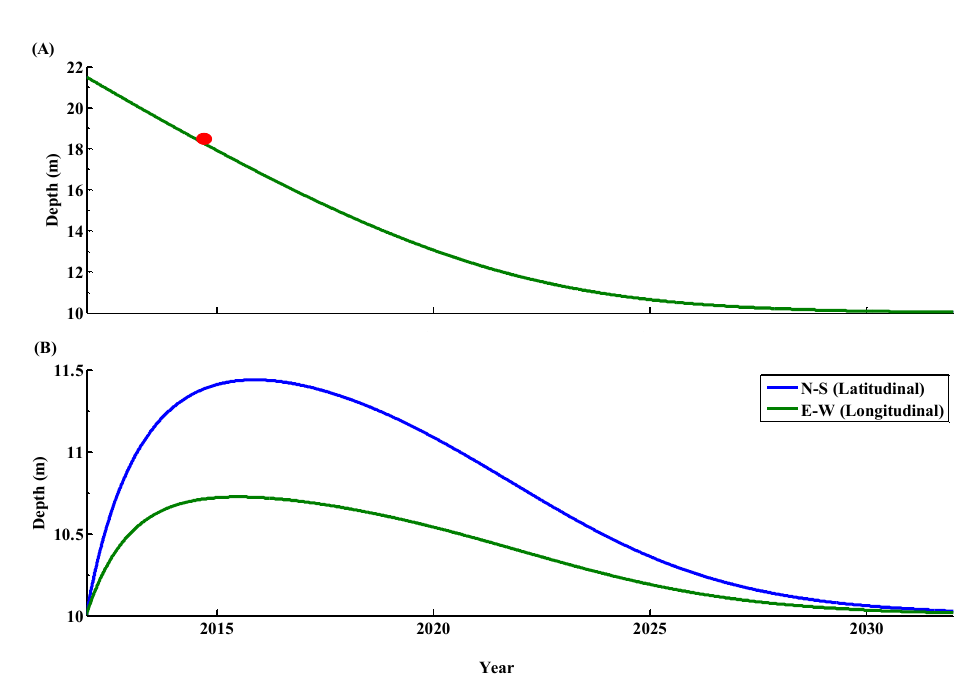
Figure 9. Model results of pit infilling. ( A ) Depth change in the pit with sediments infilling: the red dot is the measured pit depth at 2015; ( B ) depth changes of the western (green) and southern pit edge (blue).